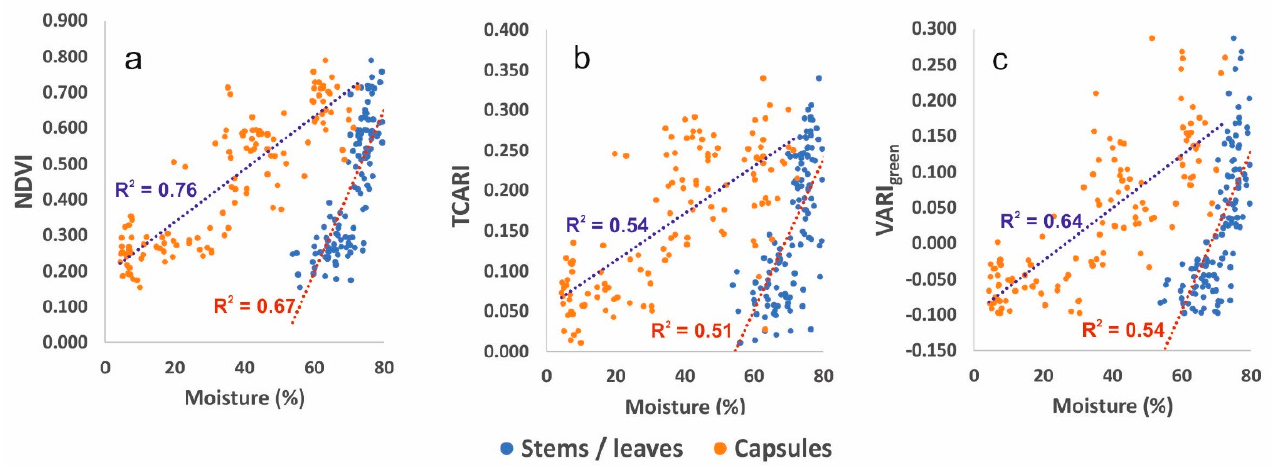
Figure 9. Scatter plots depicting the relationship between moisture content of plant parts (stems, leaves and capsules) for three representative VIs, NDVI ( a ), TCARI ( b ) and VARI green ( c ).